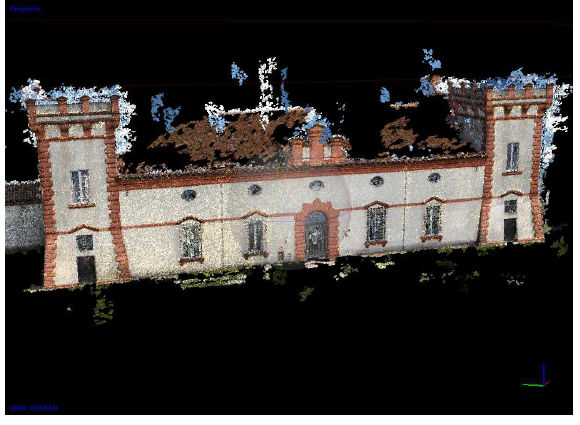
Figure 11. Point cloud obtained from model M3: front façade of the castle.